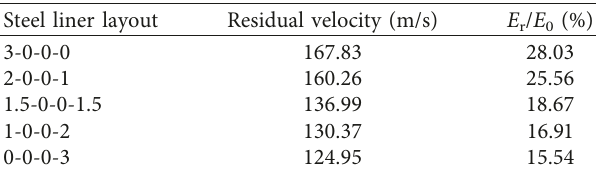
Figure 18: Time history curves of energy balance for impacting analysis (0-0-0-3). Table 7: Comparison with antiperforation performance of seg- mented targets with different steel liner layouts.